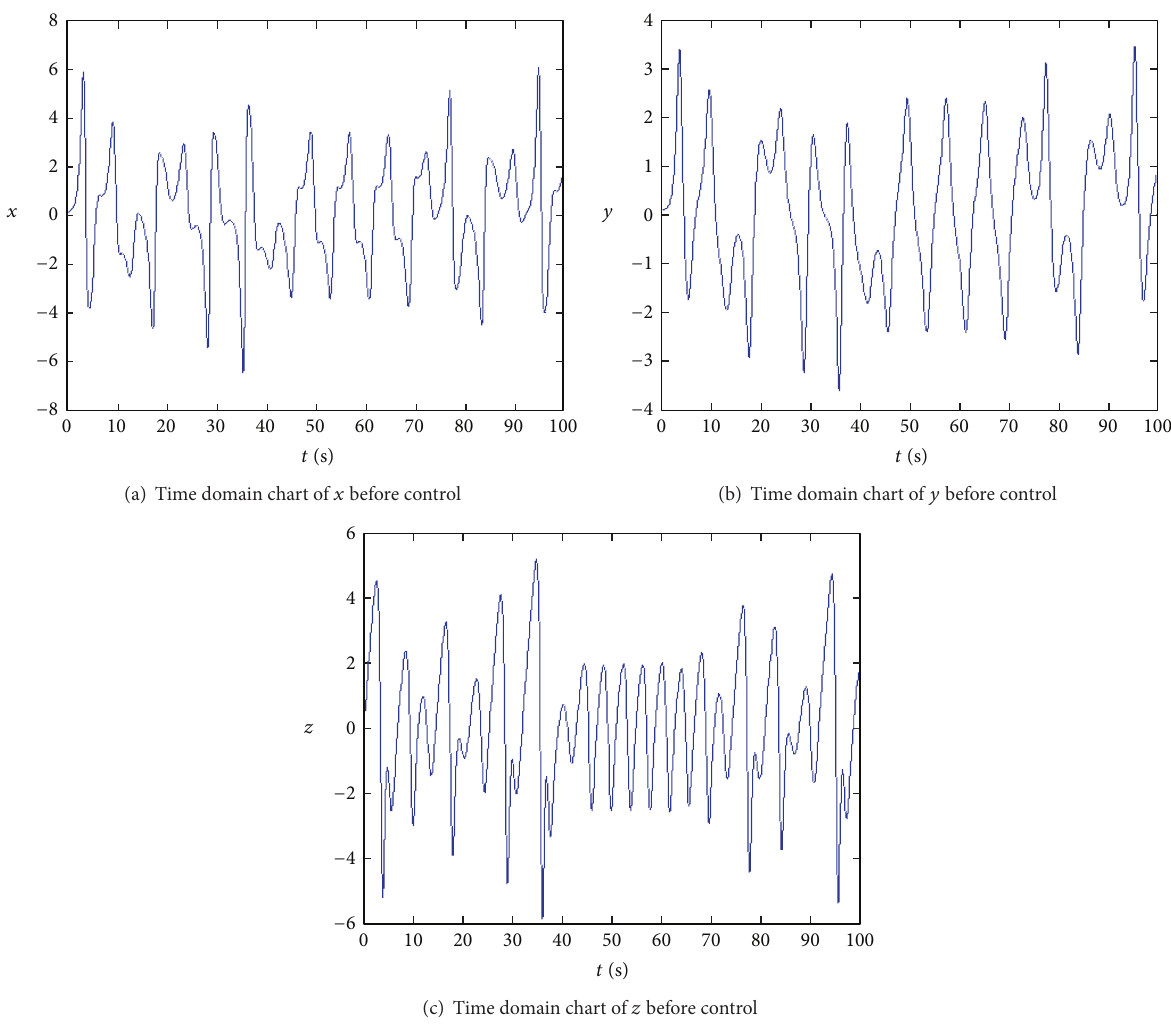
Figure 11: Time domain charts of state variables before